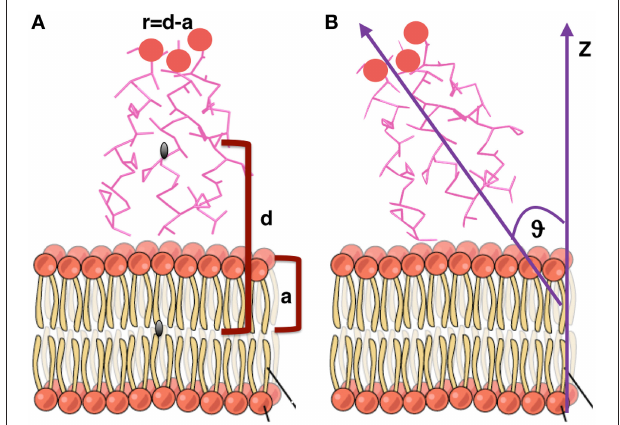
FIGURE 2 | Graphical representation of the geometrical quantities calculated to estimate orientations and distances of monomers and oligomers with respect to the membrane. (A) Distance from the membrane. (B) Orientation with respect to the membrane. Figure adapted from “The Cell Membrane”